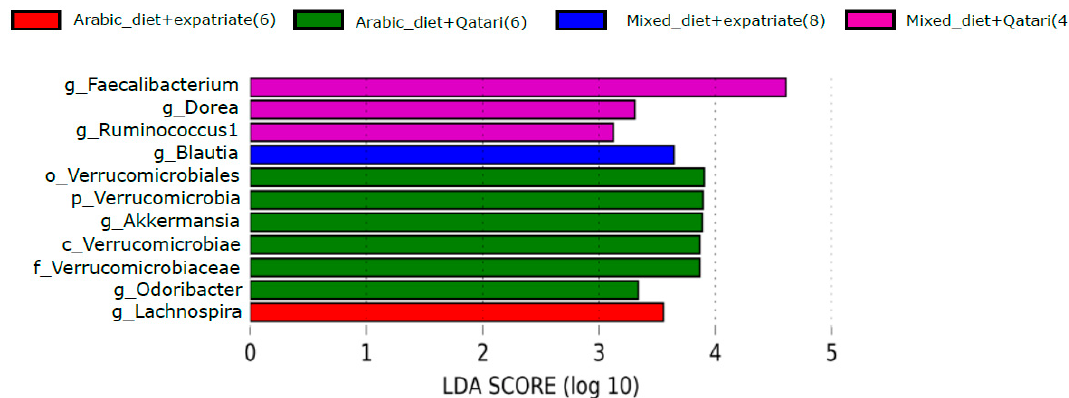
Figure 6. Impact of combination of diet and nationality on genus Akkermansia in T1DM subjects. LEfSe analysis has revealed that the Akkermansia was only enriched in the Qataris T1DM subjects, particularly in Qataris who consumed the Arabic diet. LDA cutoff value > 2.0 g_UC represents genus_unclassified.